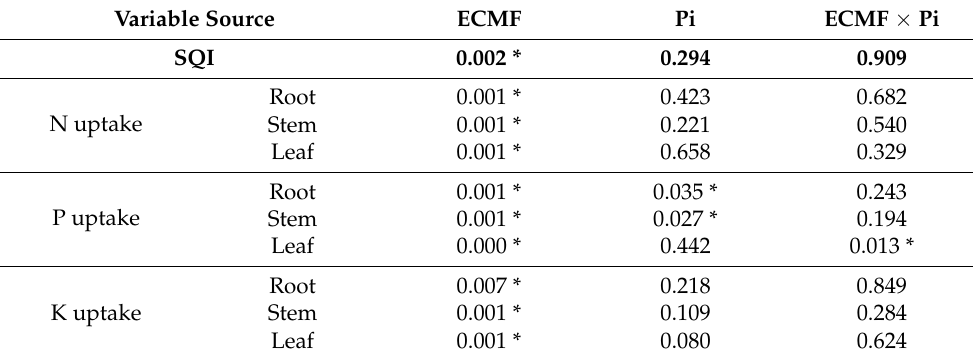
Table 3. Two-way ANOVA ( p values) for SQI and nutrient uptake (N, P, and K) in stem, root, and leaf of C. henryi